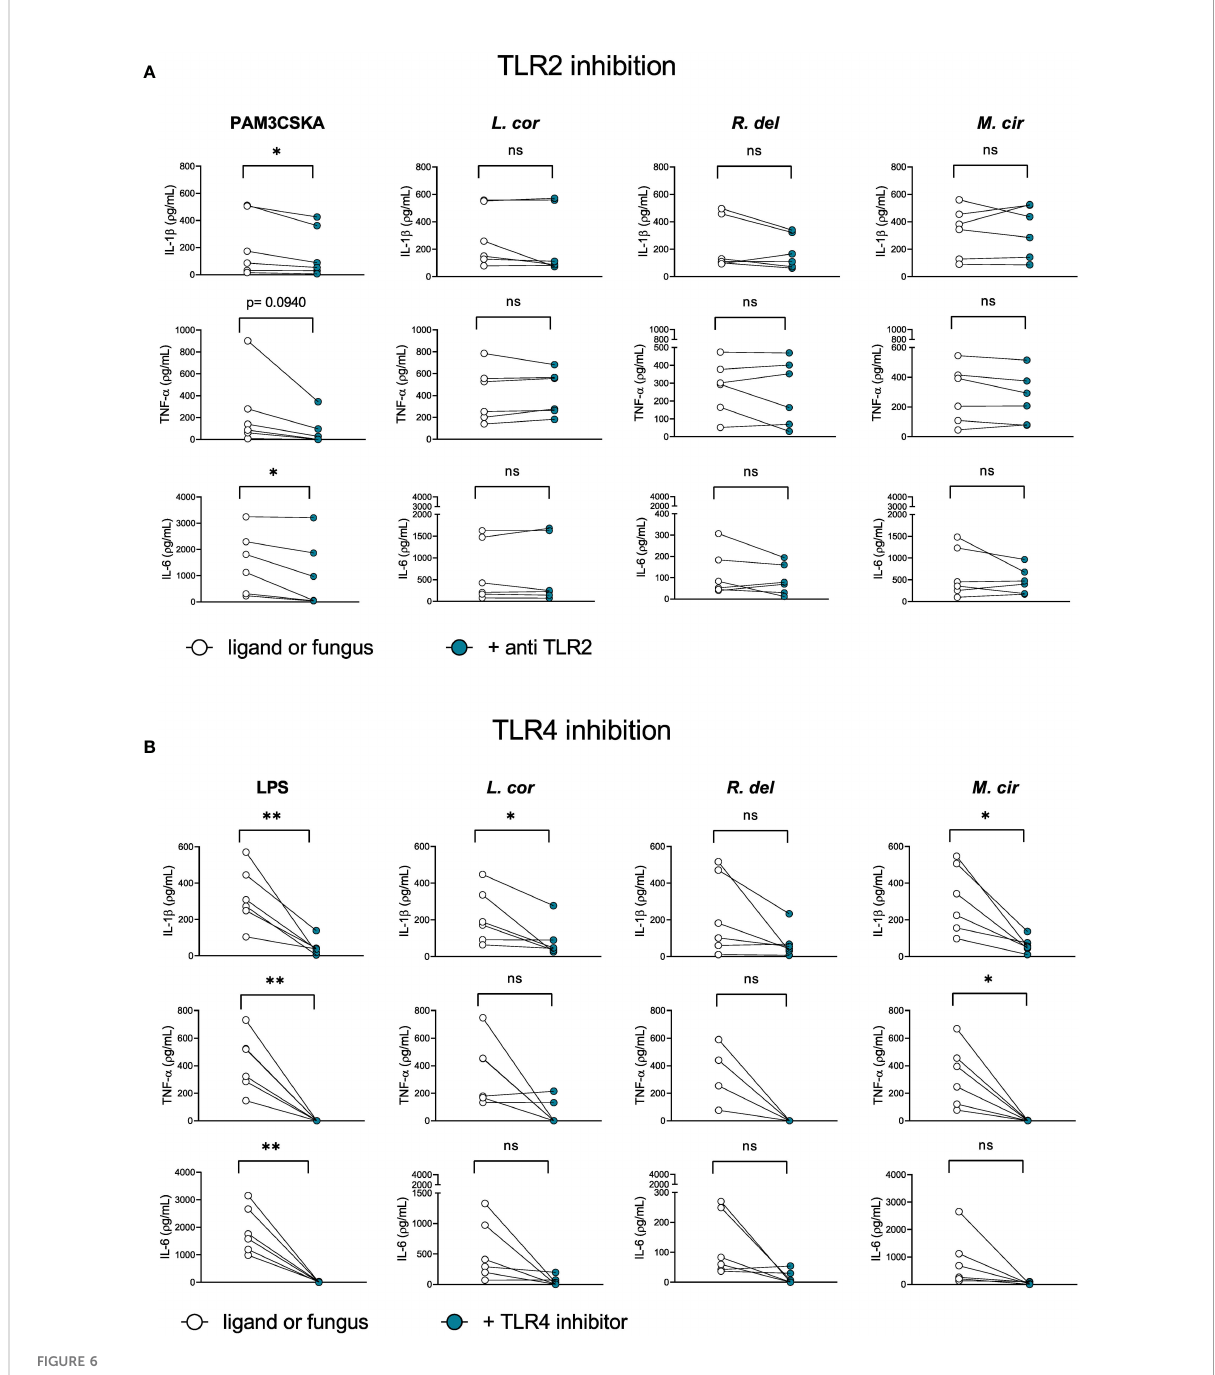
FIGURE 6 TLR4 contributes to the activation of the in fl ammatory response by primary human monocytes against L corymbifera and M. circinelloides . Neutralizing TLR2-antibody and TLR4 inhibitor were incubated for three hours before infection with the Mucorales. (A) Pro-in fl ammatory cytokines concentrations after inhibition of TLR2 or (B) TLR4. PAM3CSKA was used as a speci fi c ligand for TLR2 activation and LPS forTLR4 activation. Dots and lines represent paired values of every single donor. Data were obtained from three independent experiments, each with two or three different donors, and differences among groups were assessed by paired t-test. * p < 0,05; ** p <0,01. ns indicates not signi fi cant. L corymbifera (L. cor), R. delemar (R. del), M. circinelloides (M.